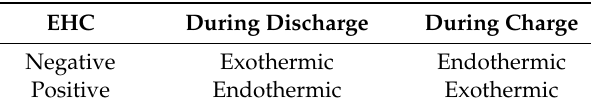
Table 2. Effect of entropic heat